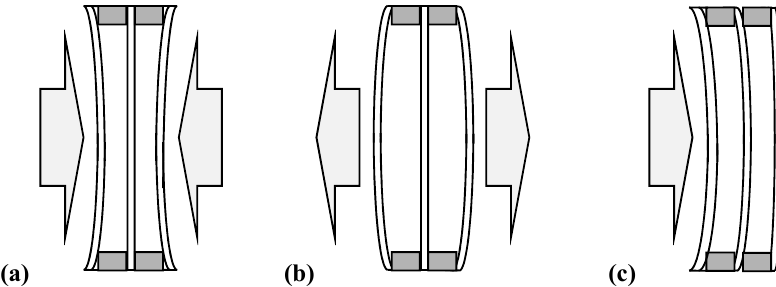
Figure 1. Typical deflections of insulating glass units: ( a ) concave form of deflection, ( b ) convex form of deflection, ( c ) deflection characteristic of wind load.